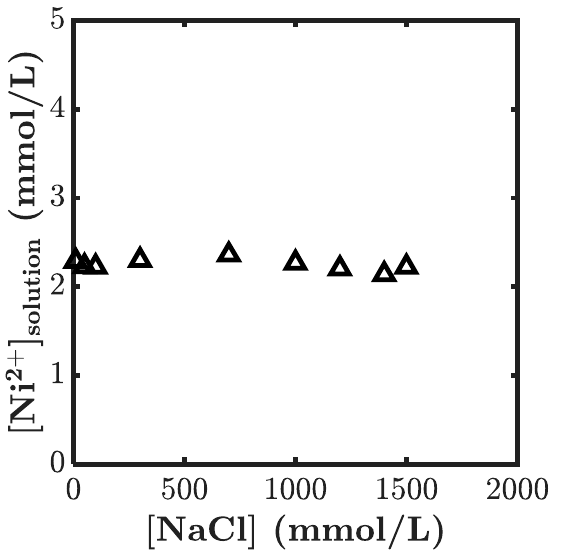
Figure 7. Ni 2+ concentration in the solution phase at equilibrium binding as a function of NaCl concentration.